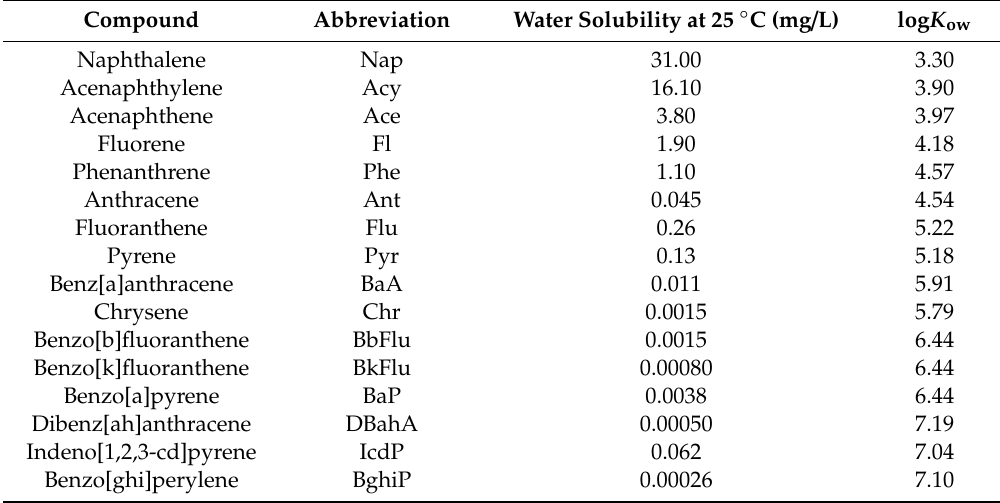
Table 3. The basic information of 16 priority polycyclic aromatic hydrocarbons (PAHs) measured in this